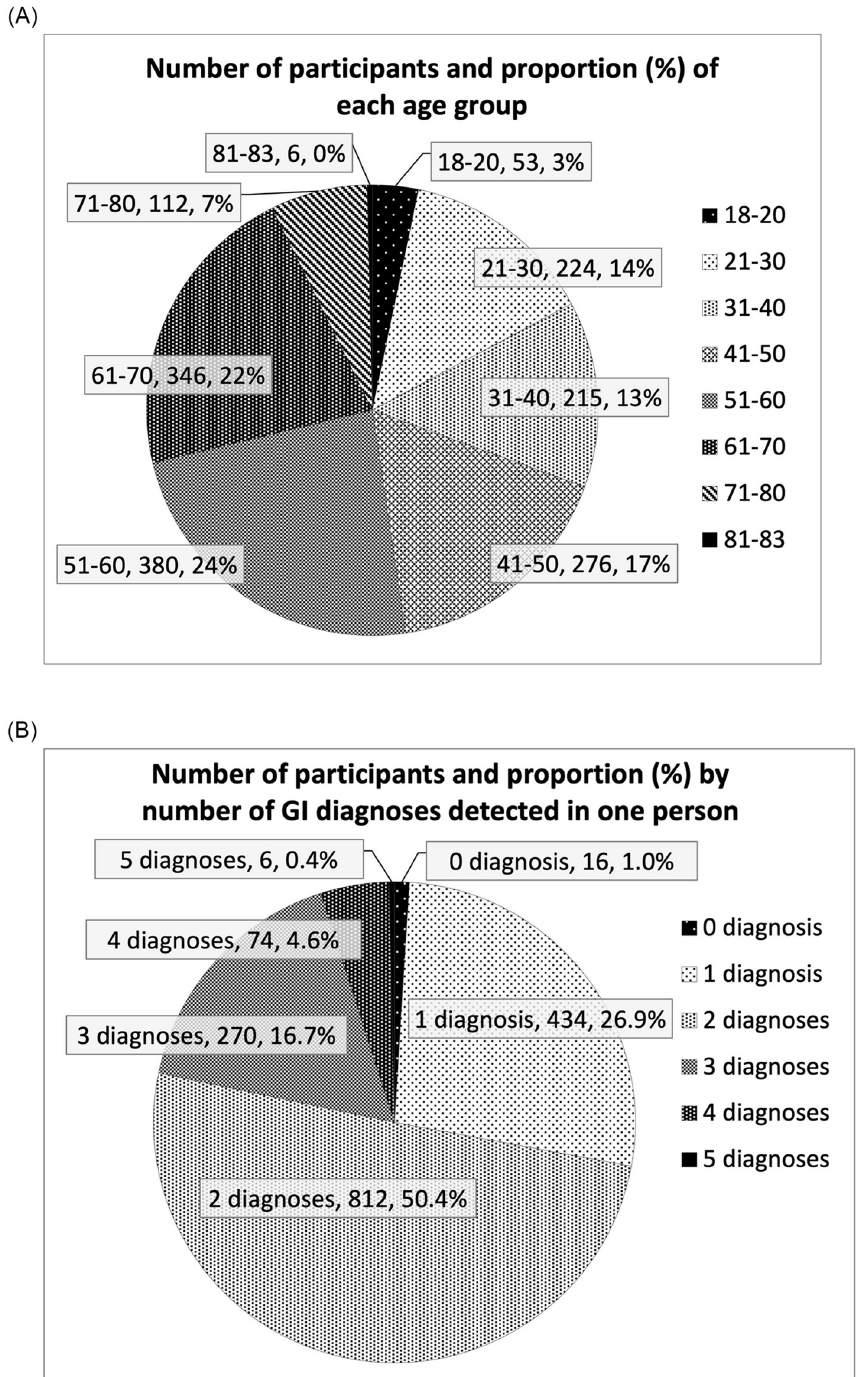
Fig 1. Background of the participants. (A) The actual number and percentage of each age range in the entire population. Most major age ranges are distributed relatively evenly, except the youngest and oldest age groups, consisting of 3% and less than 0.1% respectively, of the entire population. (B) The amount and percentage of each number of upper GI endoscopic diagnosis detected in one person. The most prevalent numbers of upper GI endoscopic diagnosis were 1, 2, and 3 diagnoses, which comprised 94%. The most prevalent number of upper GI endoscopic diagnosis indicated in one person was 2, comprising 50% of the total population.